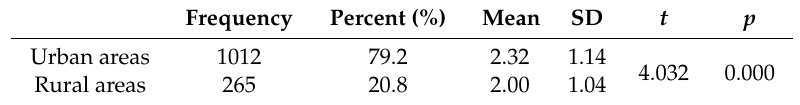
Table 5. Difference analysis for incomes between parents from urban and rural areas in